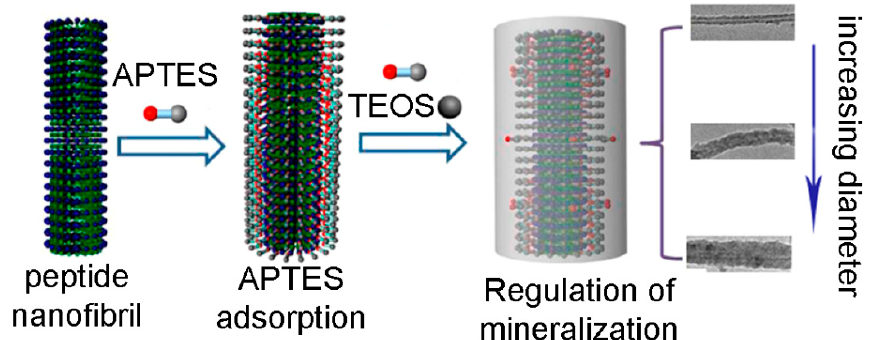
Figure 6. Silica nanotube formation on a peptide nanofibril through the adsorption of APTES and TEOS as precursors. Adapted with permission from [108]. Copyright © 2021, American Chemical Society.